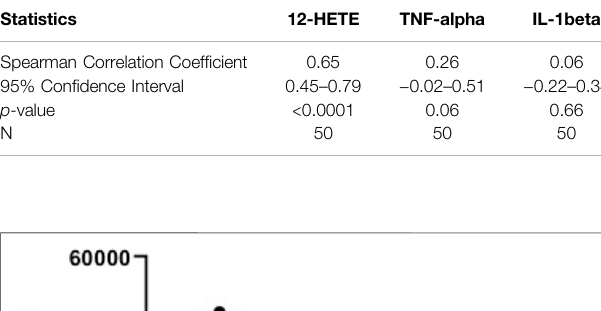
TABLE 3 | Correlation of VOE Score with plasma levels of pro-in fl ammatory molecules.